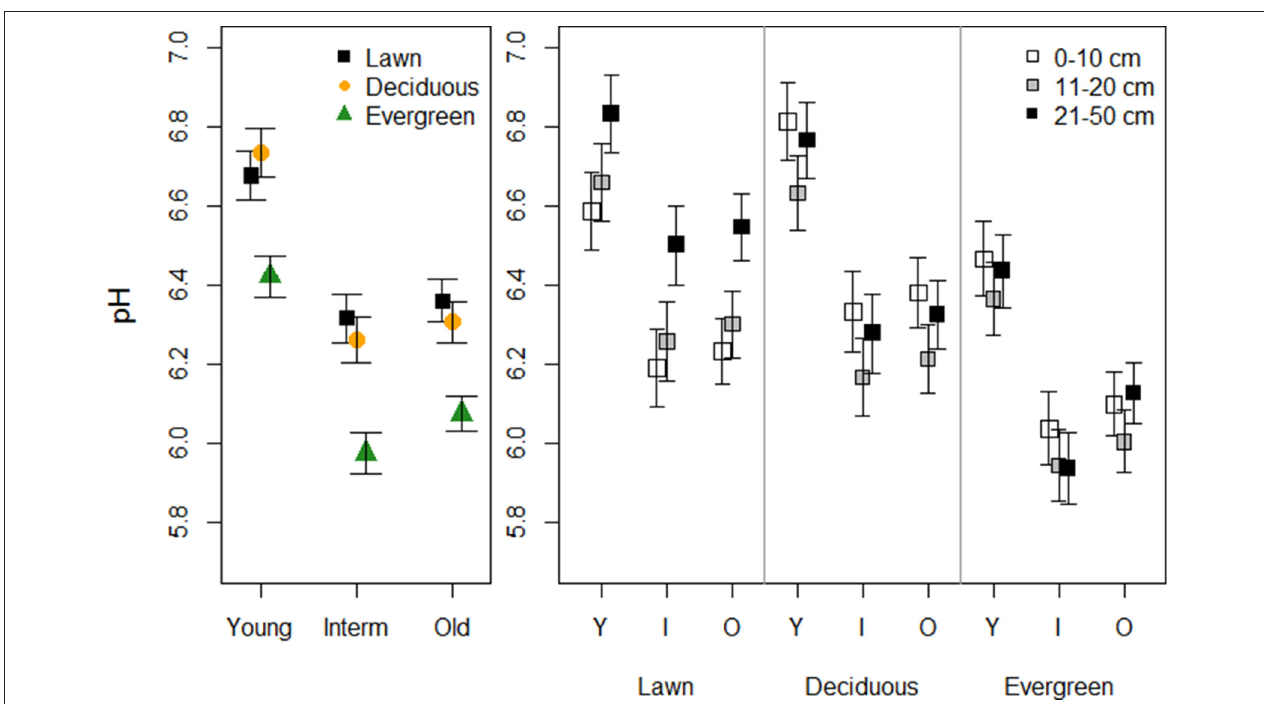
FIGURE 1 | The effects of plant functional groups and park age on soil pH. Predicted means ± SE values are presented. The panel on the left presents data with the three depth intervals pooled, while in the right panel data are shown for each depth interval separately.